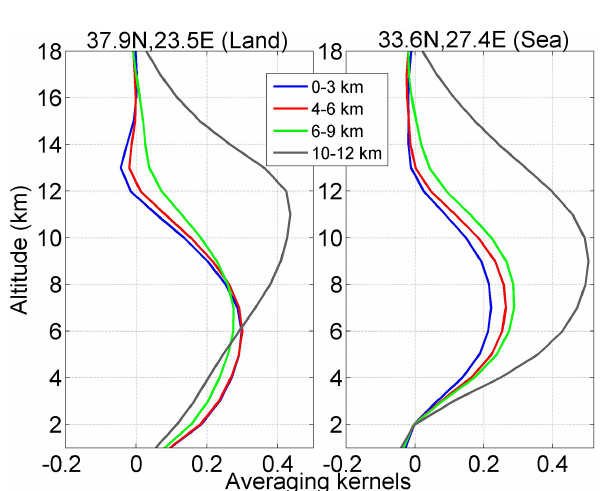
Figure 3. Random O 3 averaging kernels over the Mediterranean: the functions are for the [surface–3], [4–6], [6–9], and [10–12]km partial columns characterizing a retrieval for an observation chosen randomly above land (Greece, left panel) and above the sea (right panel) during June